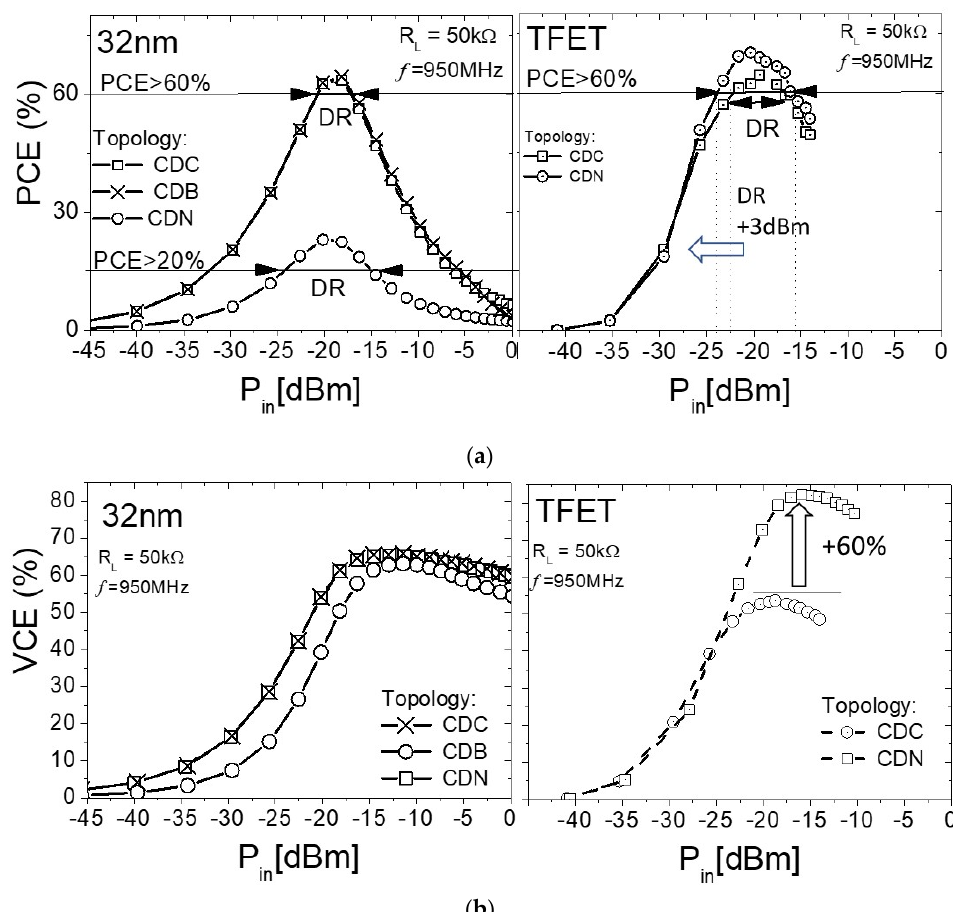
Figure 7. The FOM to assess the performance of the different topologies for different technology: ( a ) the PCE and ( b ) the VCE. In ( a ), the PCE for the TFET is the DR (>60%), which is increased from 5 dBm to 8 dBm or 3 µW to 6 µW. For the 32 nm, the DR is not improved if we use the back bias to control the V TH (CDB circuit). The PCE is importantly degraded for the CDN topology with 32 nm.